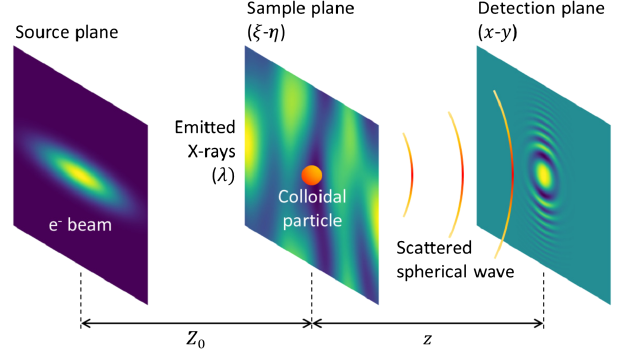
FIG. 1. Geometry for the self-referencing interference between the intense transilluminating x-ray beam and the weak scattered spherical wave. The case of interest in this paper of a horizontally elongated electron beam is depicted. From left to right: 2D electron beam distribution at the source plane, time-resolved field distribution of the emitted x rays impinging onto the scatterer, and finally time-integrated single-scatterer interference